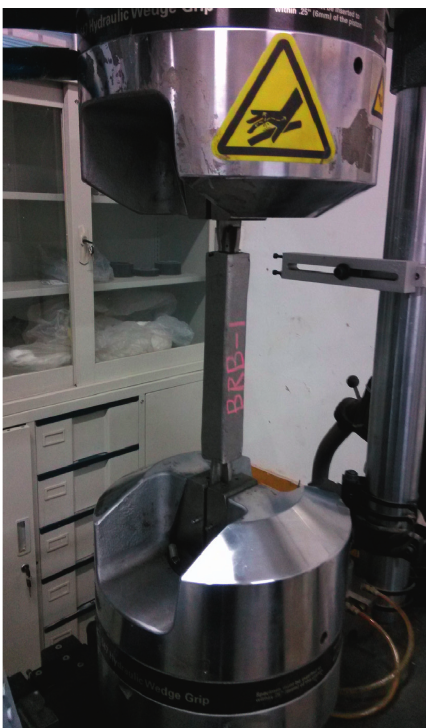
Figure 14: Loading of the specimens.